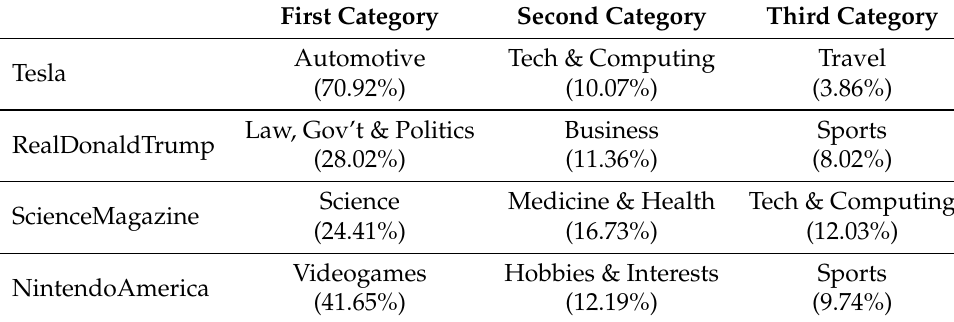
Table 7. Final results with different